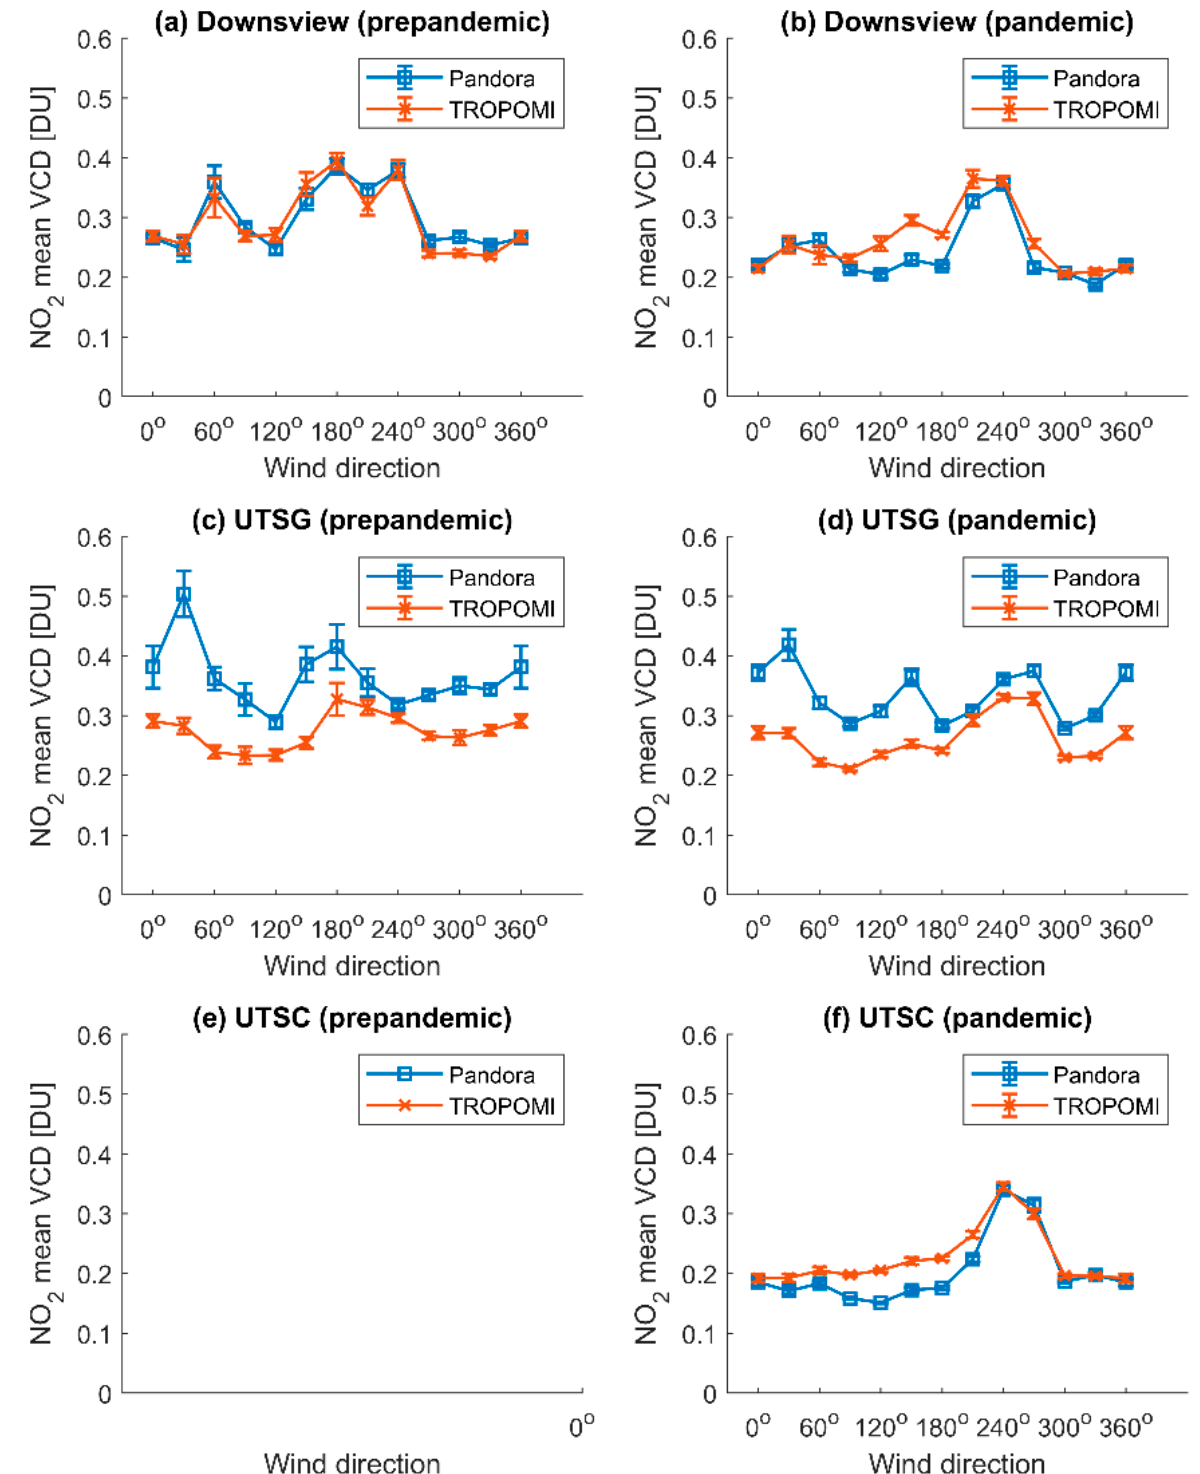
Figure A8. TROPOMI (S5P-PAL standard product) and Pandora NO 2 total column (VCD) measurements at Downsview, UTSG, and UTSC binned by wind direction, using data from before the pandemic ( a , c , e ) and since pandemic ( b , d , f ). Error bars are the standard error of the mean. Unlike Figures 4 and 6, only Pandora measurements taken within ±1 h around the TROPOMI overpass time were used (observations from 15 March to 15 September for each year).